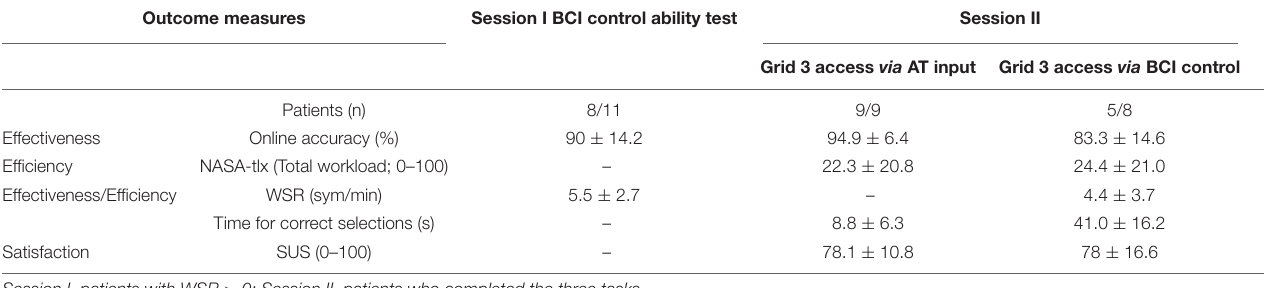
TABLE 3 | The mean ( ± SD) group results, including the patients who completed each session. Outcome measures Session I BCI control ability test Session II